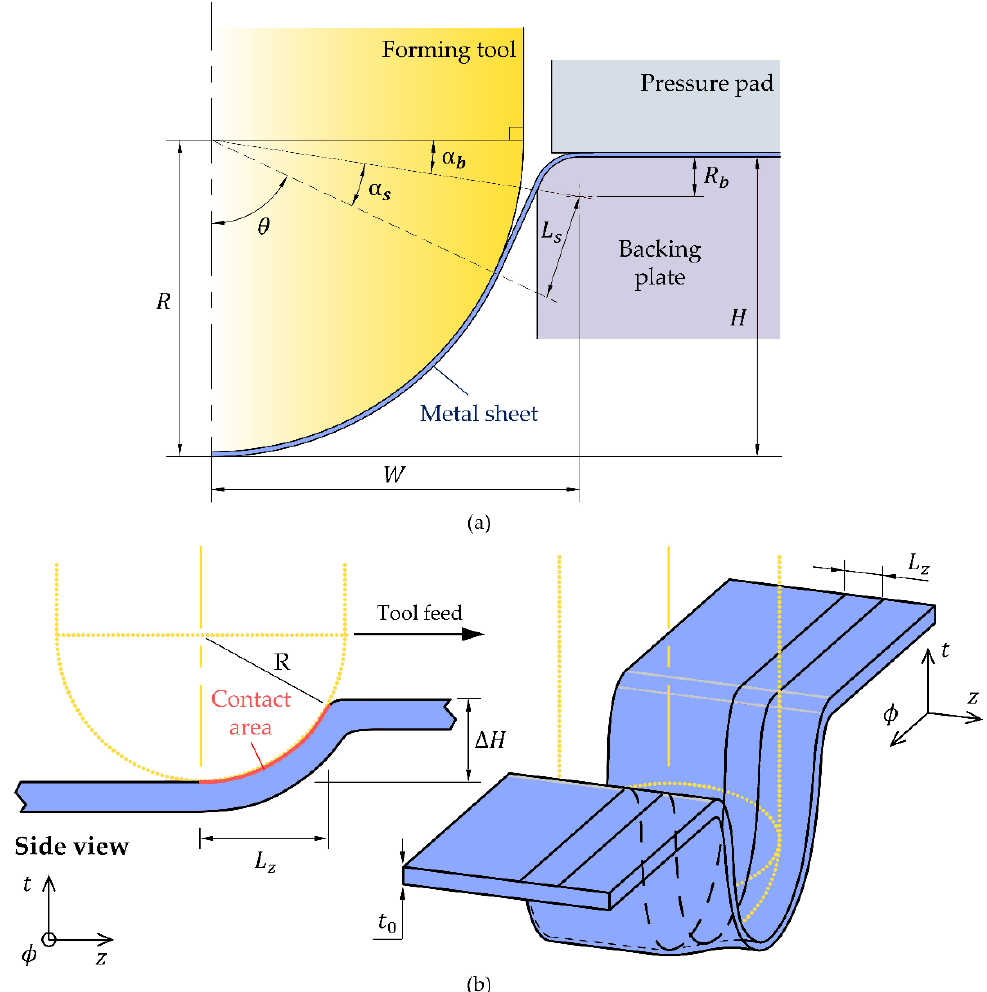
Figure 5. ( a ) Schematic representation of the stiffening groove with main notation; ( b ) schematic representation of the area corresponding to the local contact between the tool and the sheet placed immediately ahead (z-direction).